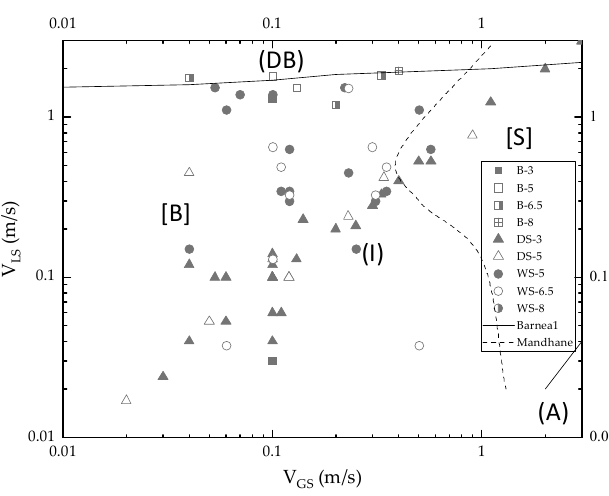
Figure 9. The flow pattern of gas-liquid two-phase in a horizontal circular tube. The crossed line areas on the map show the areas of bubble flow and annular flow.